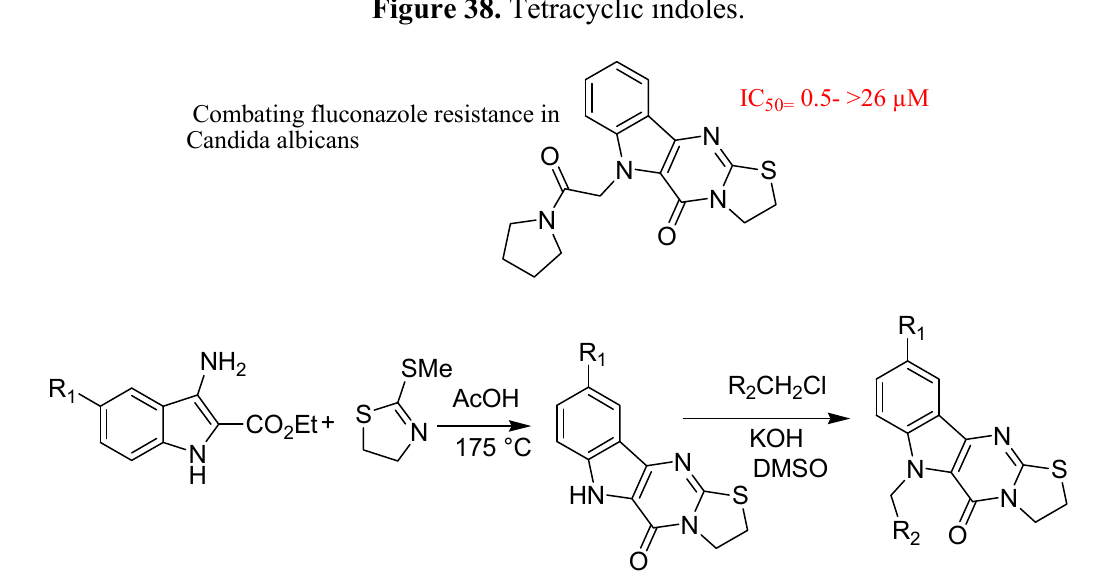
Figure 38. Tetracyclic indoles.